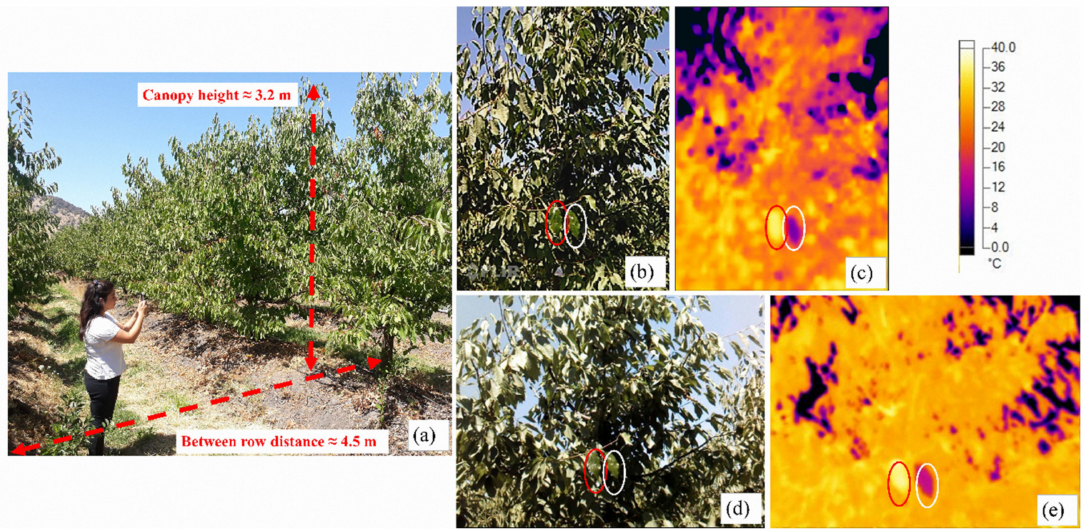
Figure 1. Examples of ( a ) image shot from the side of each tree row; false-color thermal images obtained from low ( c ) and high resolution ( e ) thermal cameras, and the corresponding RGB images ( b , d ). The “wet leaf” is depicted in each thermal image using a white circle; meanwhile, the “dry leaf” is shown in a red circle. Both images ( b – e ), are from the same tree, and they were captured at the same time using the two thermal cameras, the day of the year (DOY) 44, in